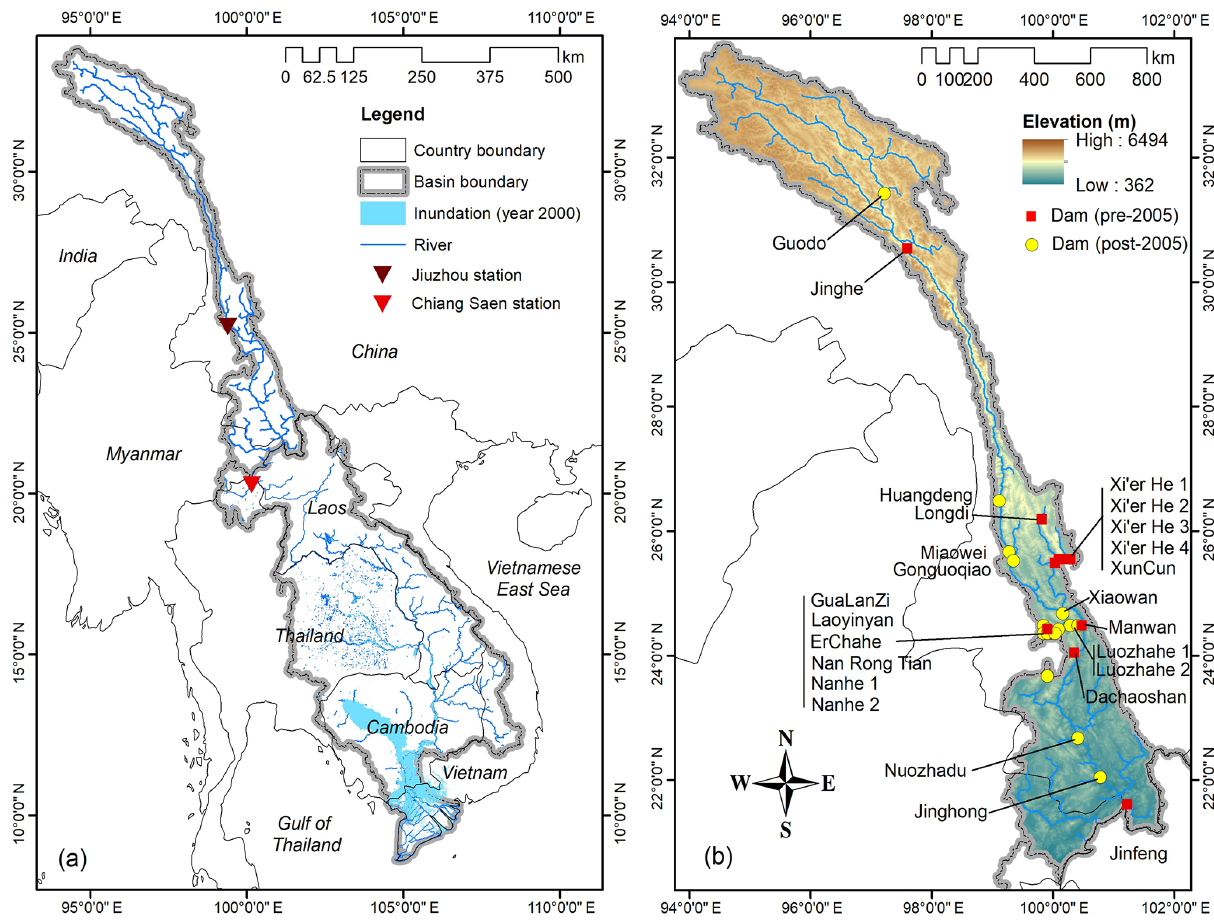
Figure 1. Mekong river basin (a) and elevation map and location of the hydropower dams in the upper Mekong basin (b) . The red squares denote dams built before 2005 (and therefore included in our study), while the yellow circles indicate dams built after